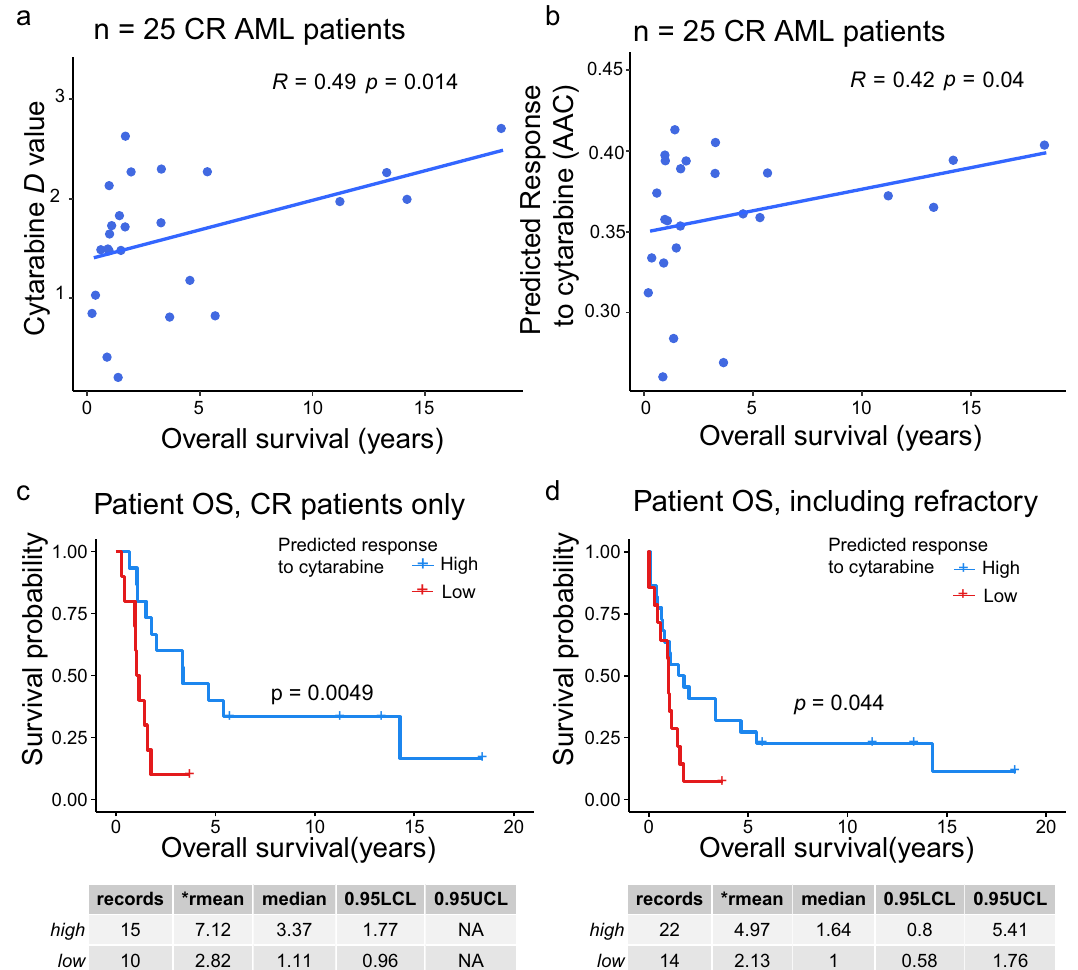
Fig. 7 Cytarabine DRUML model predicts prognosis of AML patients treated with cytarabine. DRUML was used to predict responses to cytarabine from phosphoproteomics data obtained from 36 AML patients in triplicate by Casado et al. (PRIDE PXD005978). Prediction was obtained from the average prediction derived from random forest, principal component regression and partial least squares models. a , b Correlation between overall patient survival and cytarabine D values ( a ) or DRUML predicted responses ( b ) in patients that underwent complete remission (CR) and received consolidation therapy ( p values by Spearman, n = 25). c , d Kaplan – Meier survival curves of patients with high (blue lines) or low (red lines) DRUML predicted cytarabine responses for CR ( c ) and for all ( d ) patients ( p values by log-rank test). Mean of predicted cytarabine AAC was used as cut-off for patient strati fi